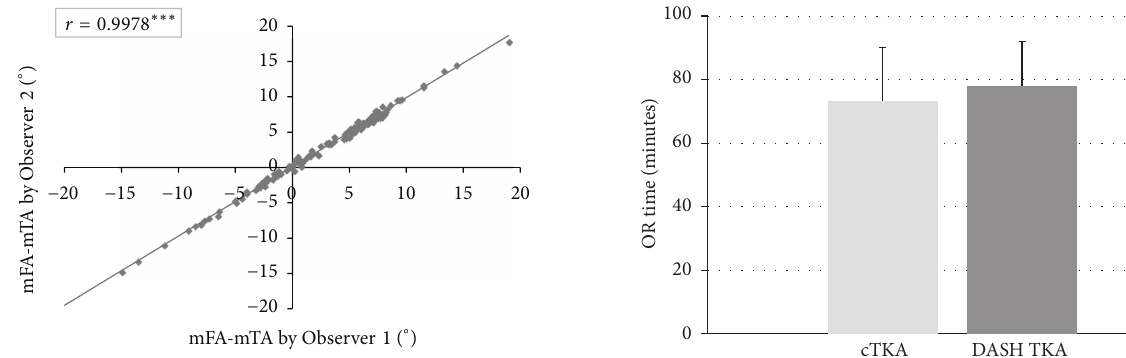
Figure 6: Duration of surgery for conventional TKA (cTKA, 𝑛 = 125 ) and TKA using the navigation system DASH (DASH TKA, 𝑛 = 40 ). Means + SD are shown ( 𝑝 = 0.12 by Student’s 𝑡